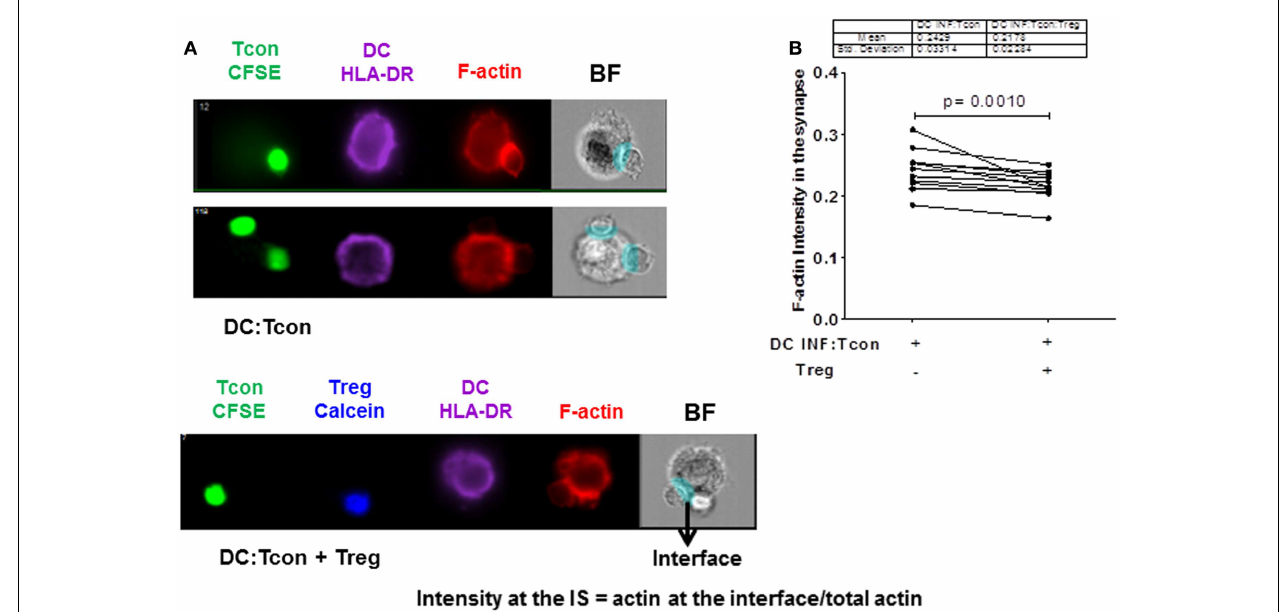
cluster. (A) The upper panel shows actin polymerization at IS in one DC:1Tcon and one DC:2Tcon cluster middle panel, the lower panel shows actin polymerization in the DC:Tcon IS in a DC:Tcon:Treg cluster. (B) Summary of 11 independent experiments, comparing actin polymerization in the absence and presence ofTreg. p Value corresponds to a paired t